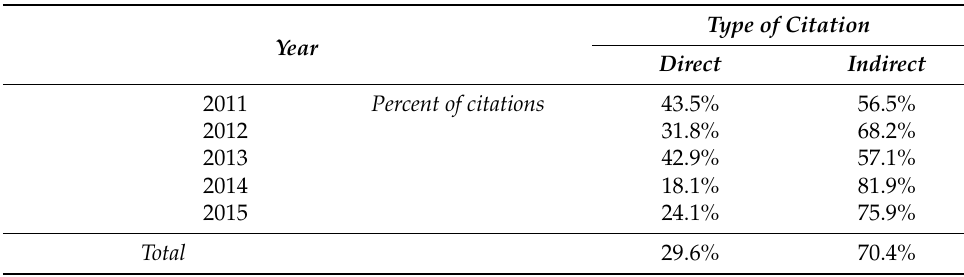
Table 1. Percent of traffic citations per year by method of issuance (direct vs. indirect) from 2011 to 2015.